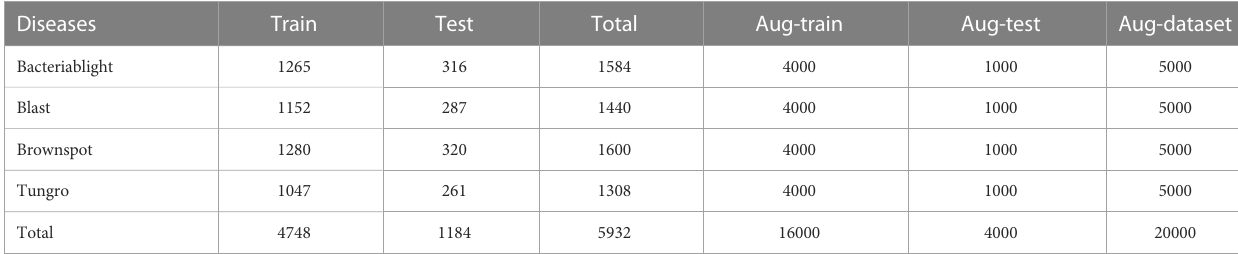
TABLE 1 Rice disease dataset.